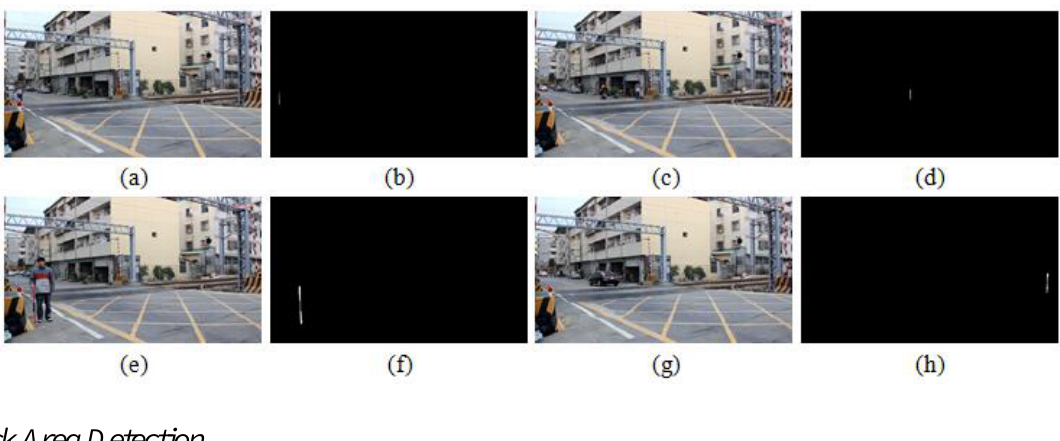
Figure 9. The test object with length 100 cm for the terrain drop compensation: ( a ) the test rod on rear-left; ( b ) the extracted test rod image of (a); ( c ) the test rod on rear-right; ( d ) the extracted test rod image of (c); ( e ) the test rod on front-left; ( f ) the extracted test rod image corresponding to (e); ( g ) the test rod on front-right; ( h ) the extracted test rod image corresponding to